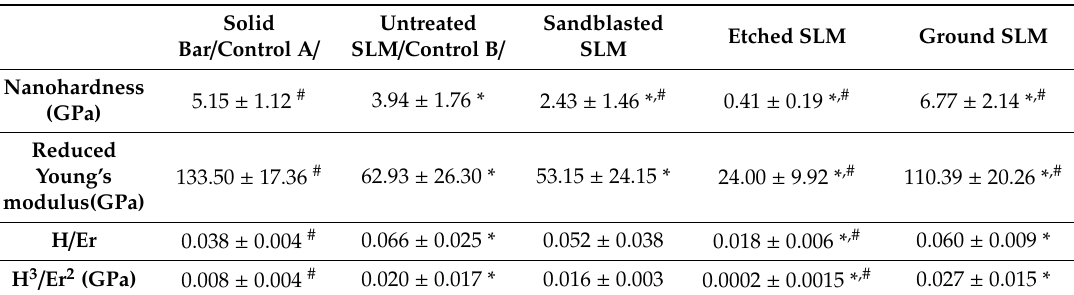
Table 5. Nanomechanical properties (nanohardness and reduced Young’s modulus) of investigated surface-modified titanium alloy specimens (n = 25; * significantly di ff erent from control A ( p < 0.05); # significantly di ff erent from control B ( p <